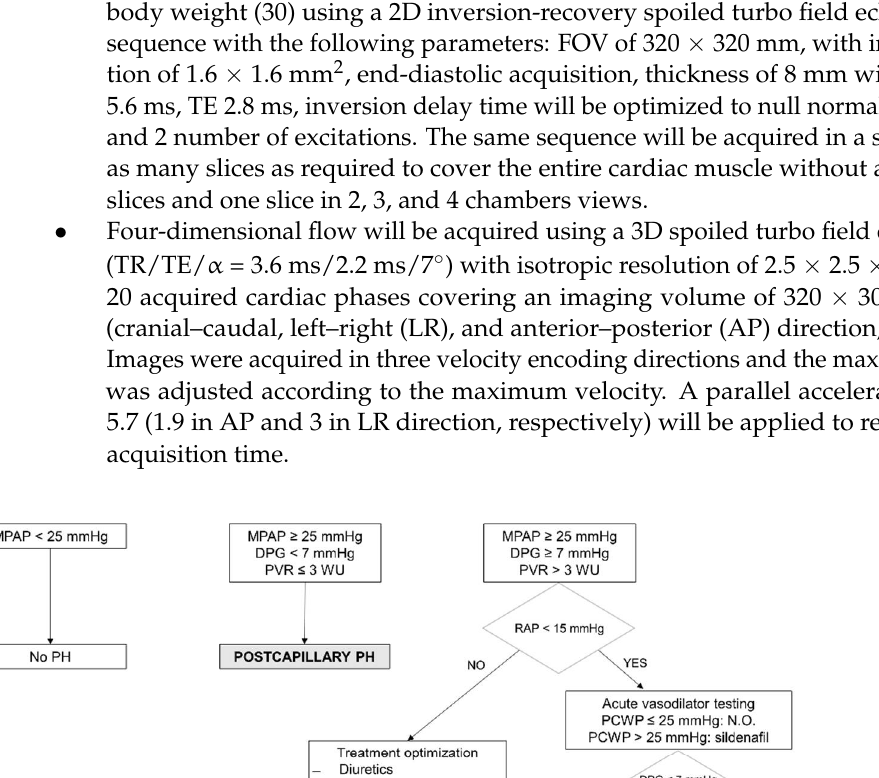
4 Table 2. Definition of pulmonary hypertension. Pulmonary Hypertension